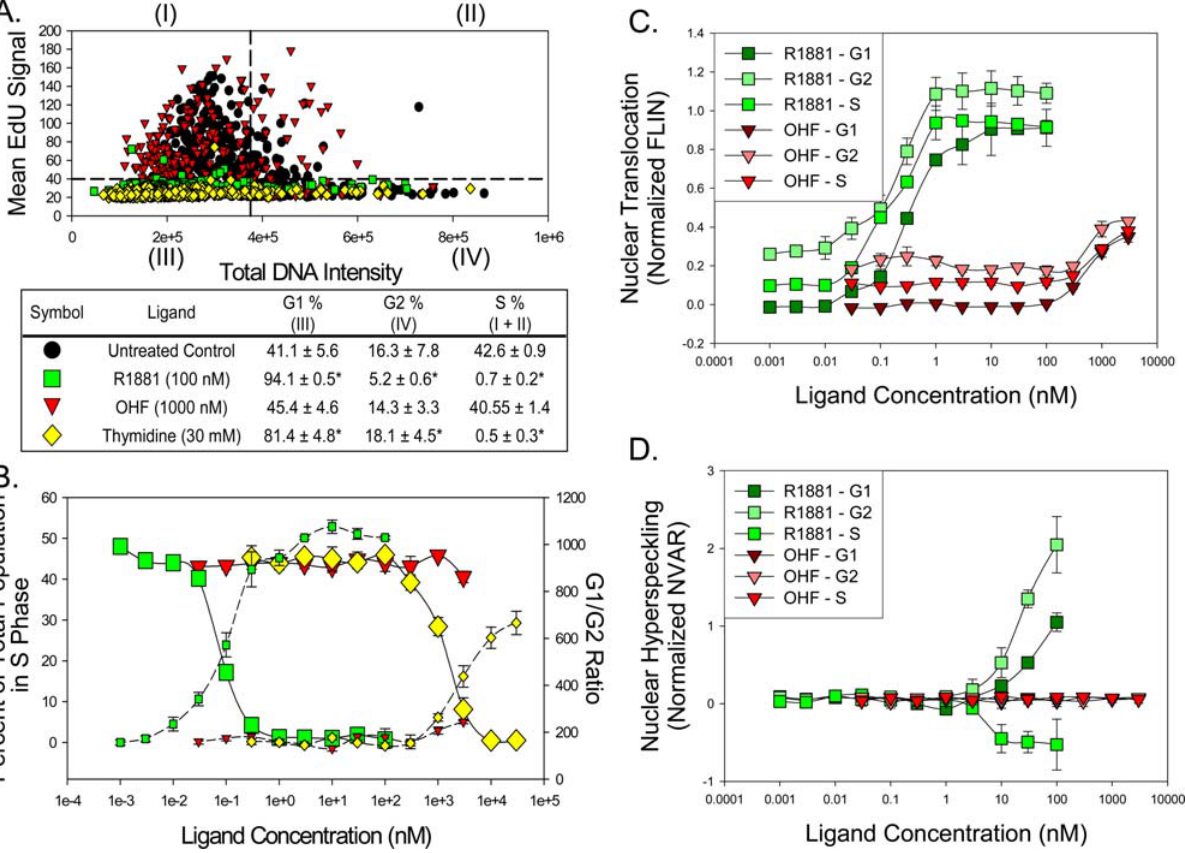
Figure 7. Analysis of the relationship between observed responses, and cell cycle in asynchronous HeLa GFP-AR cells treated with R1881 (green square), o-hydroxyflutamide (red triangle), or thymidine (yellow diamond). A. Biparametric dot-plot analysis of total DNA content (total DAPI signal per nucleus) and 5-ethynyl-2 9 -deoxyuridine (EdU) incorporation. Dotted lines represent thresholds used to divide cells with either low or high DNA content (vertical line) or cells positively stained for EdU (horizontal line). The percent of cells in each quadrant with each treatment are represented in the associated table. B. Concentration-responsecurvesofthe percent ofcells inS phase(large markers) andG1/G2 ratio (small markers) after an 18 hr treatment. C and D. Concentration-response curves examining nuclear translocation response (C) and nuclear hyperspeckling (D) in G1, S phase, and G2 cells treated with R1881 and o-hydroxyflutamide. Results normalized to positive and negative controls (all cells).